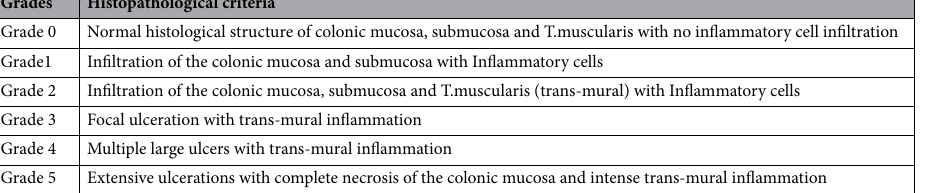
Table 1. Pathological grading system of colonic